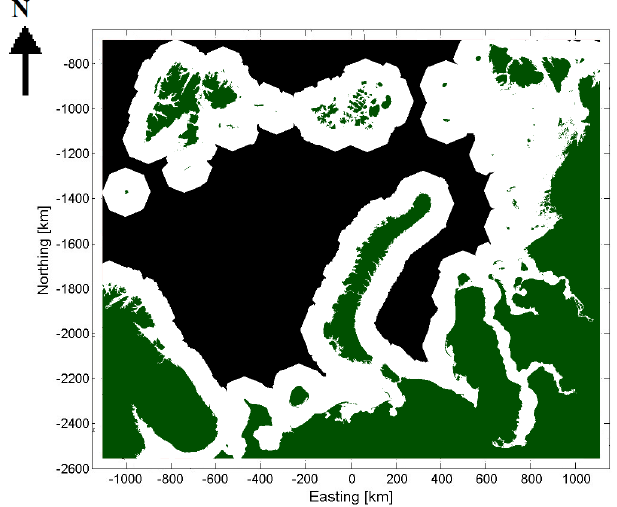
Figure 4. Mask used to locate the areas where LFI is searched. White areas indicate the LFI search area and green areas are